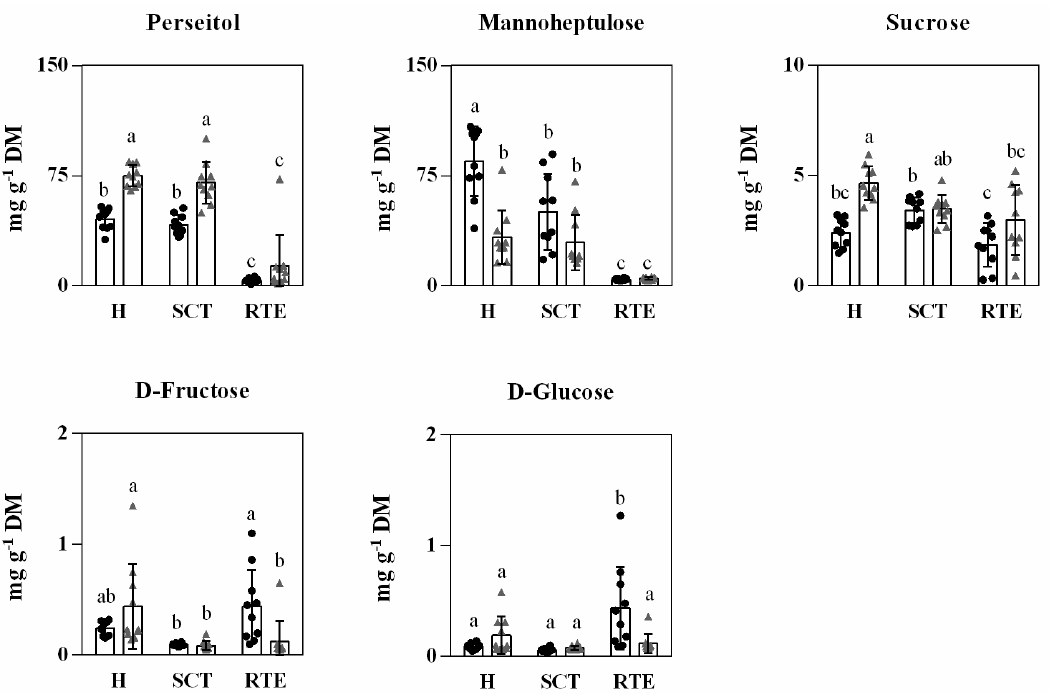
Figure 4. Abundance of main sugars in Hass avocado from two countries, Spain (black dots) and Chile (gray triangle) at harvest (H), after supply chain type (SCT) and at the ready-to-eat stage (RTE). Each column represents an average of 10 biological replicates and the standard deviation (SD) is represented by bars. Different letters indicate significant differences ( p < 0.05) determined by ANOVA, followed by Tukey’s test.